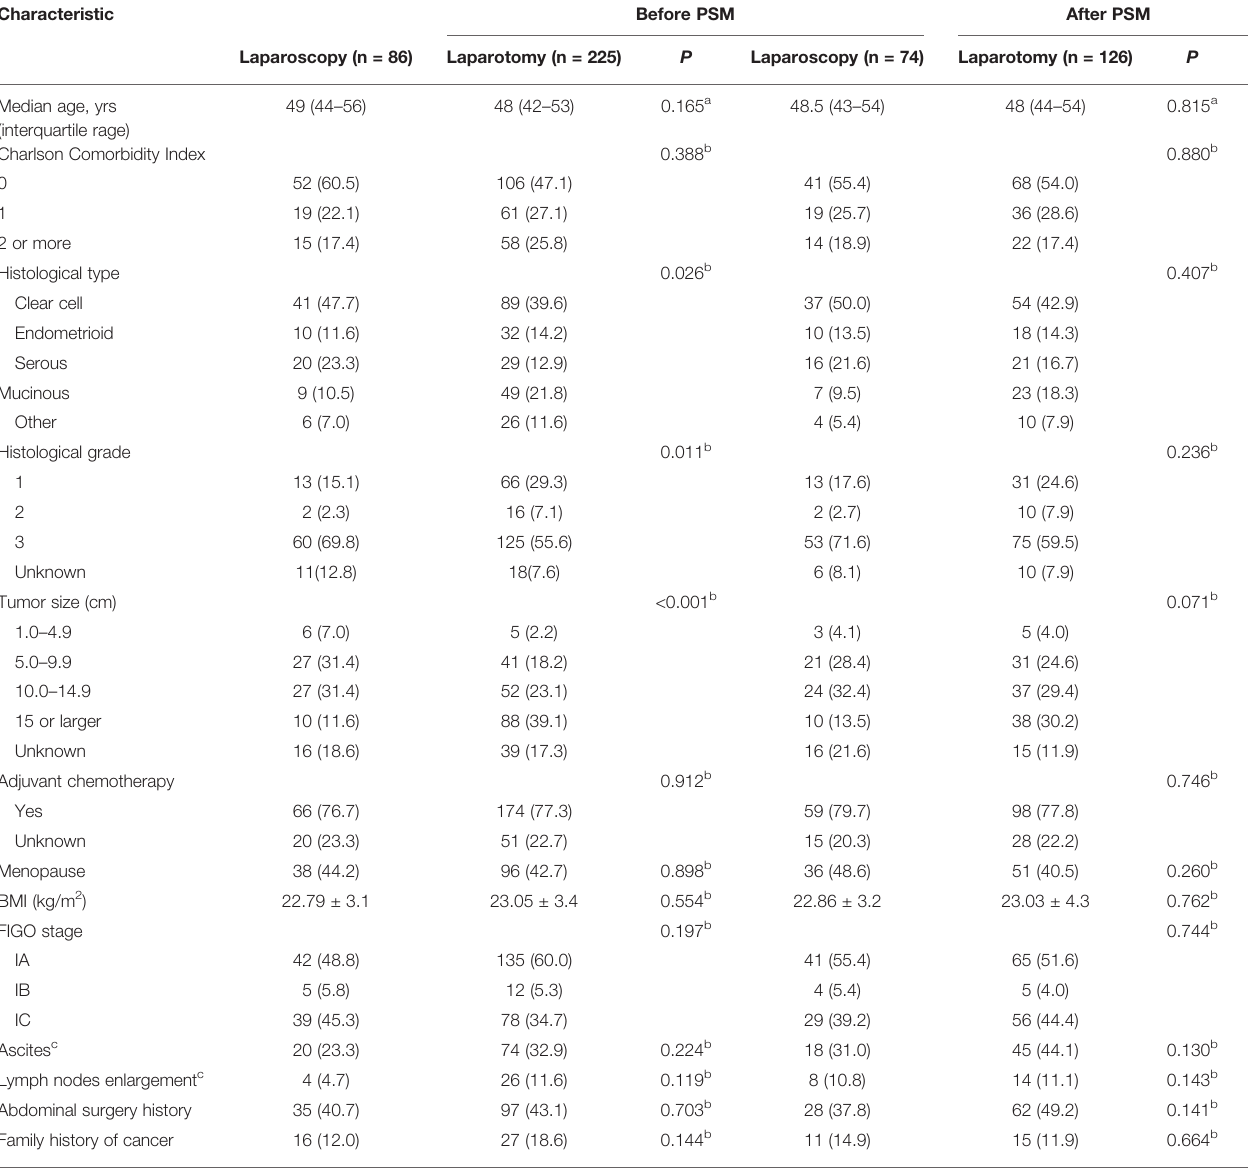
TABLE 1 | Characteristics of patients undergoing surgery of presumed stage I epithelial ovarian cancer surgical approach before and after propensity score matching.